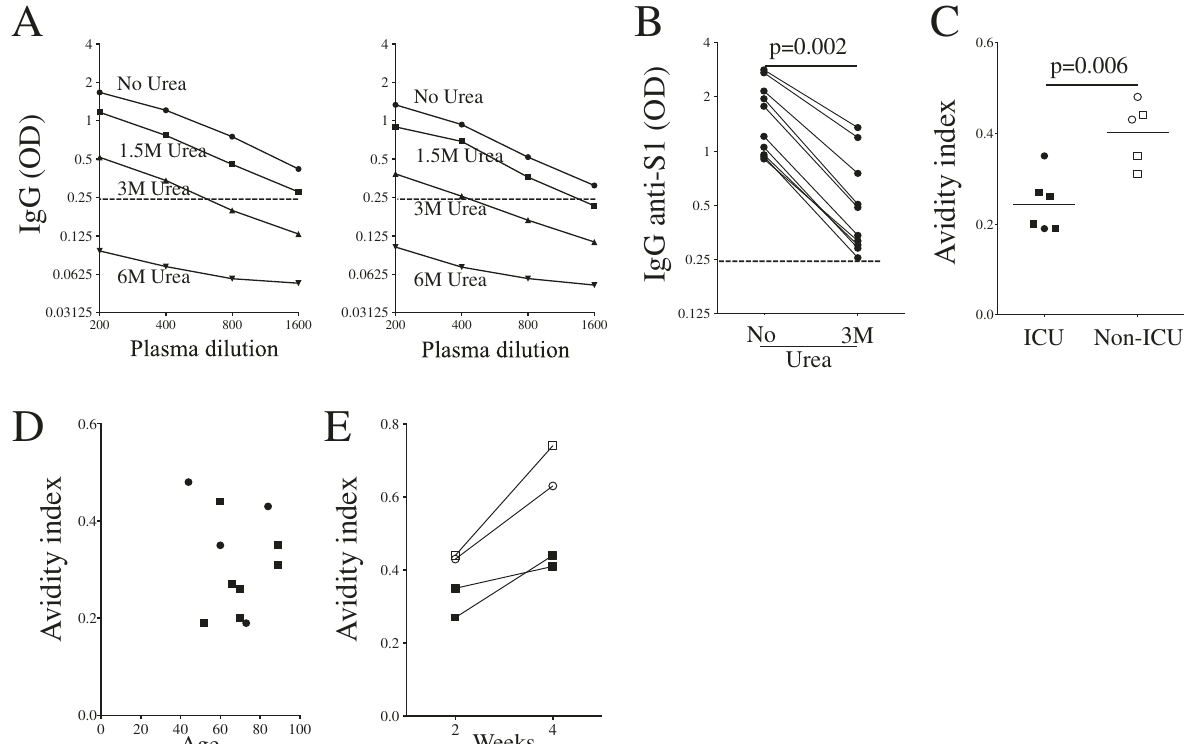
Fig. 6 Avidity. A Speci fi c anti-S1 IgG detected from the diluted plasma of two ICU individuals in the absence (No Urea) or presence of increasing concentrations of Urea (1.5, 3, and 6 M) are shown. B Speci fi c S1 IgG in the absence or presence of urea at 3 M. Plasma was diluted to 1/400. A nonparametric paired Mann – Whitney test was used for comparison. C The avidity index (ratio: OD with 3 M of urea/OD without urea) was measured in ICU and non-ICU individuals from panel B . A nonparametric Mann – Whitney test was used to compare ICU and non-ICU patients. D Dot-plot showing the avidity index against the age of the patients (Circles are females and squares are males). Each dot represents an individual. E In four individuals (ICU, fi lled symbol and non-ICU, blank symbol) the avidity index was measured at 2 and 4 weeks after symptom onset as shown in Fig.